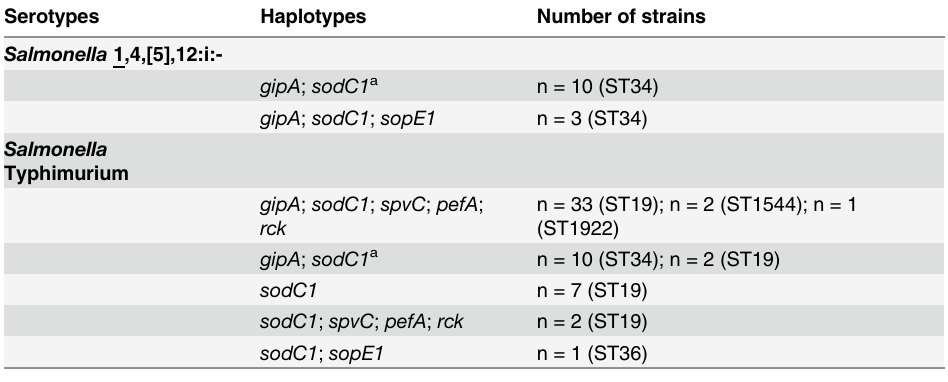
Table 2. Virulotyping: most commonly detected haplotypes.